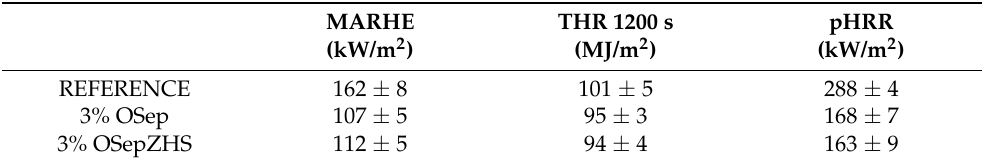
Table 3. Cone calorimeter and smoke chamber results. MARHE (kW/m 2 ): Maximum Average Rate of Heat Emission. THR 1200 s (MJ/m 2 ): Total Heat Release. pHRR(kW/m 2 ): Peak of heat release rate.